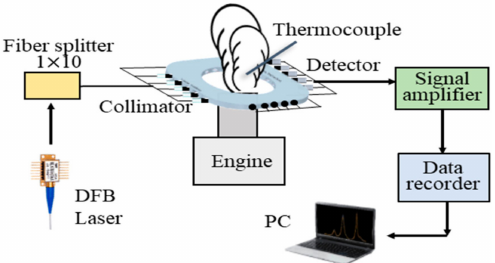
Figure 2. Schematic diagram of the experimental setup using tunable diode laser absorption spectroscopy (TDLAS).